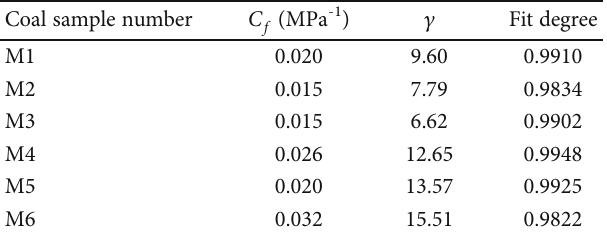
Table 3: Theoretical parameters of coal sample permeability calculation. Coal sample